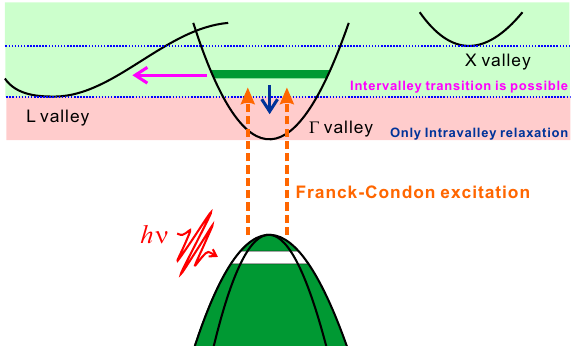
Figure 2. A schematic view of band structure of GaAs is shown. According to the distribution of photo-injected electrons, intravalley and intervalley scatterings become possible. For more details, see the